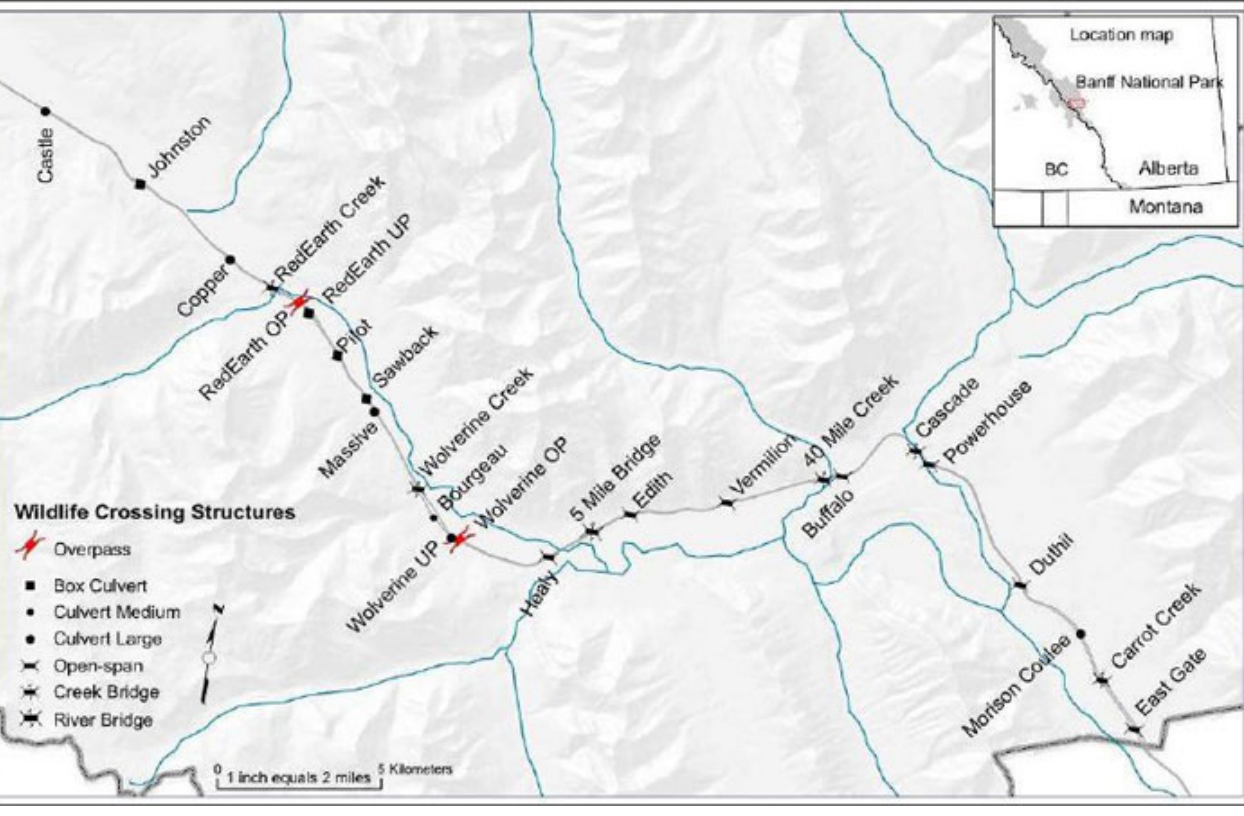
Fig. 1. Location of 23 engineered wildlife crossing structures along the Trans-Canada Highway in Banff National Park, Alberta, Canada. Cascade, Buffalo, and Edith were excluded from hair sampling. Non- engineered underpasses are 5-Mile Bridge and 40-Mile Creek (Map prepared by B.